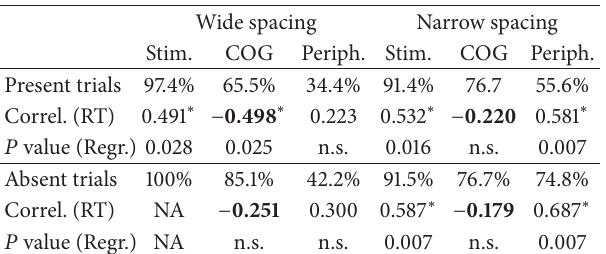
Table 1: Correlations of RT with the proportion of trials with stim- ulus fixations, central void fixations, and peripheral void